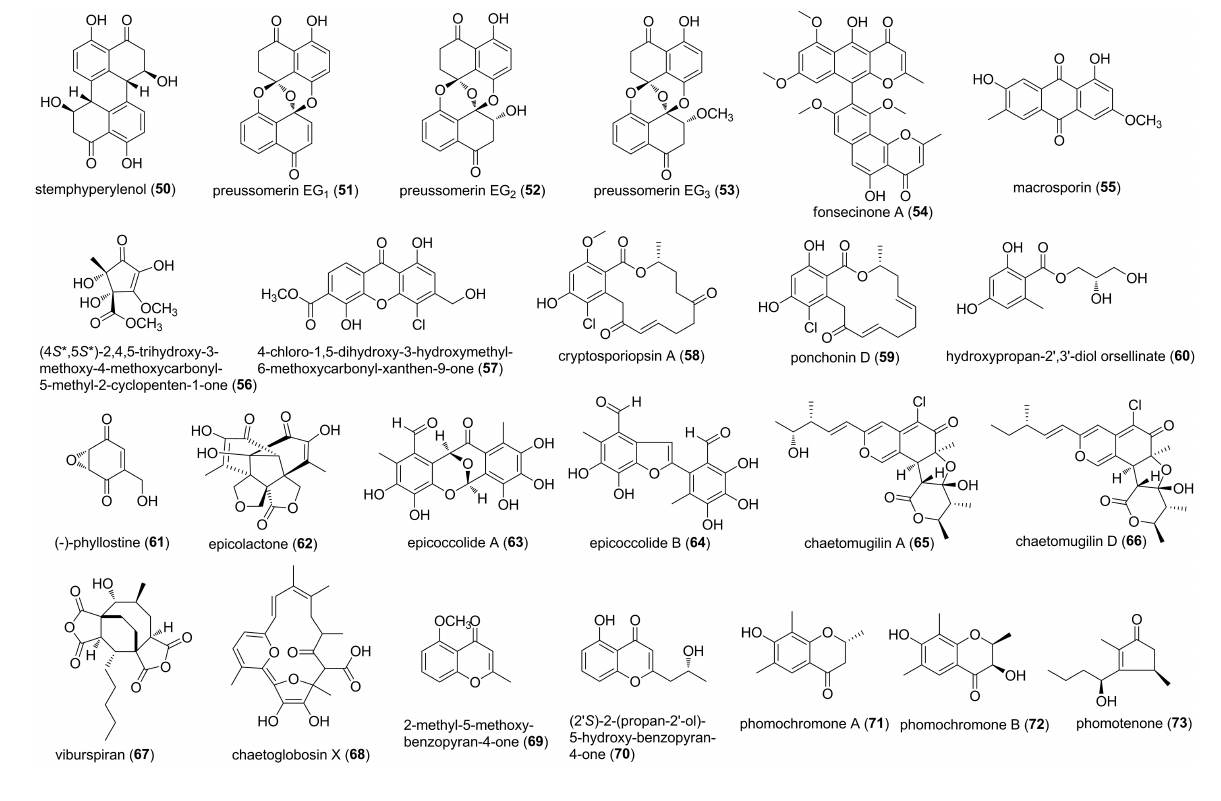
FIGURE 4 | Polyketides characterized from endophytic fungi